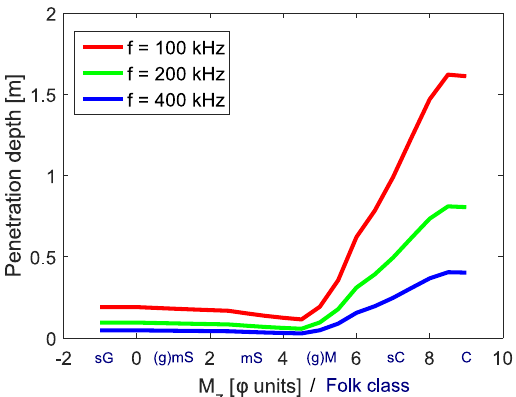
Figure 18. Signal penetration versus mean grain size. Signal penetration is calculated from an empirical equation for acoustic attenuation in marine sediments [38]. Folk classes are approximately assigned to mean grain size values: sG (sandy gravel), (g)mS (gravelly muddy sand), mS (muddy sand), (g)M (gravelly mud), sC (sandy clay) and C